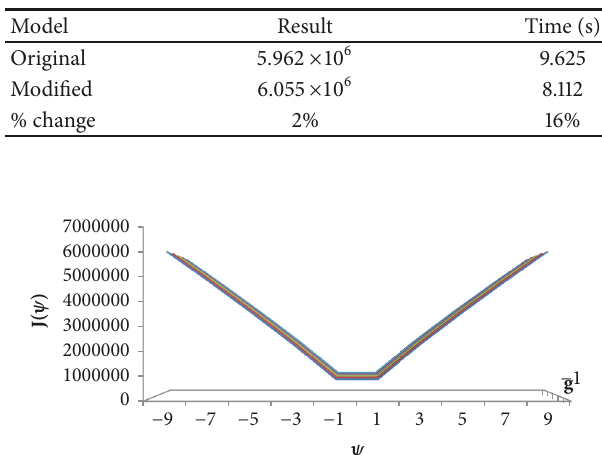
Table 6: Execution time for solving model.